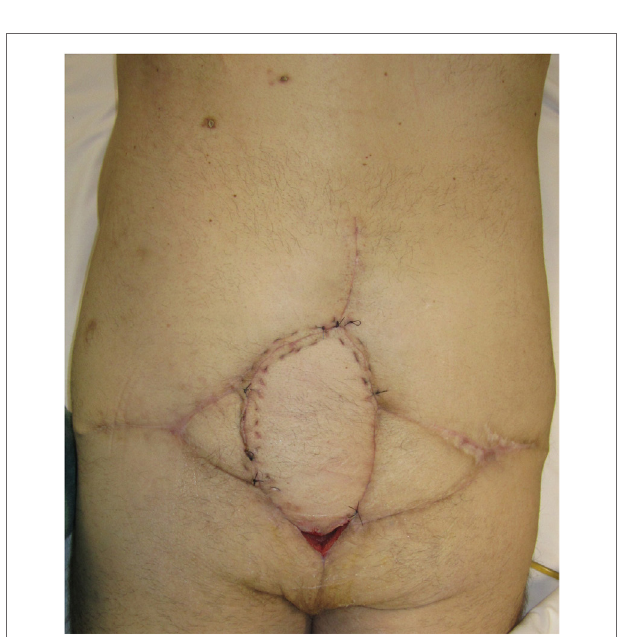
FigUre 7 | Flap inset into sacral defect, with adjacent remnants of previous locoregional reconstructive flaps